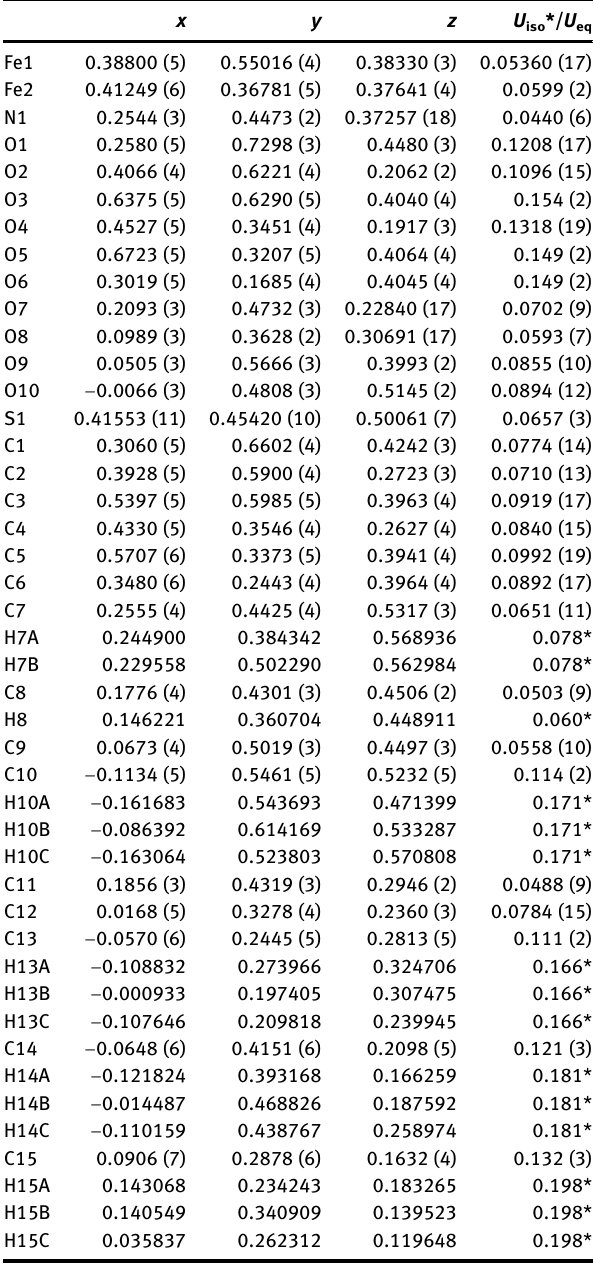
Table  : Fractional atomic coordinates and isotropic or equivalent isotropic displacement parameters (Å 